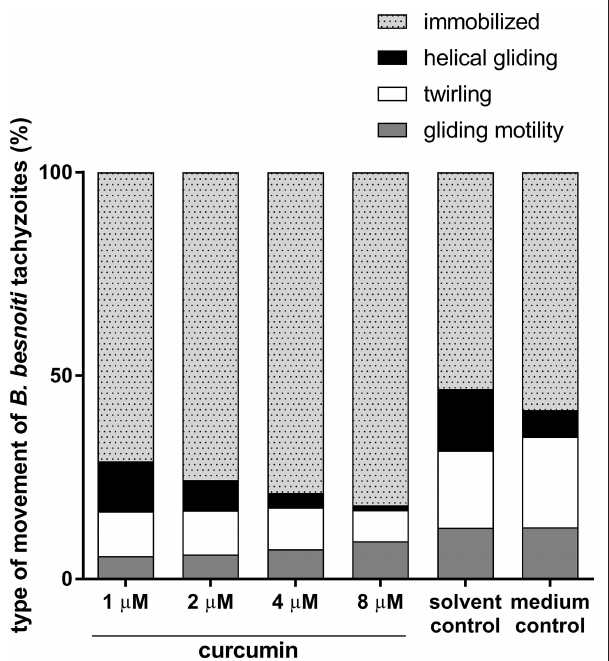
FIGURE 1 | Effects of curcumin treatments on different types of B. besnoiti tachyzoites movement. B. besnoiti tachyzoites were treated with curcumin different doses (1–8 µ M) and controlled microscopically for immobilization, helical gliding, twirling and gliding